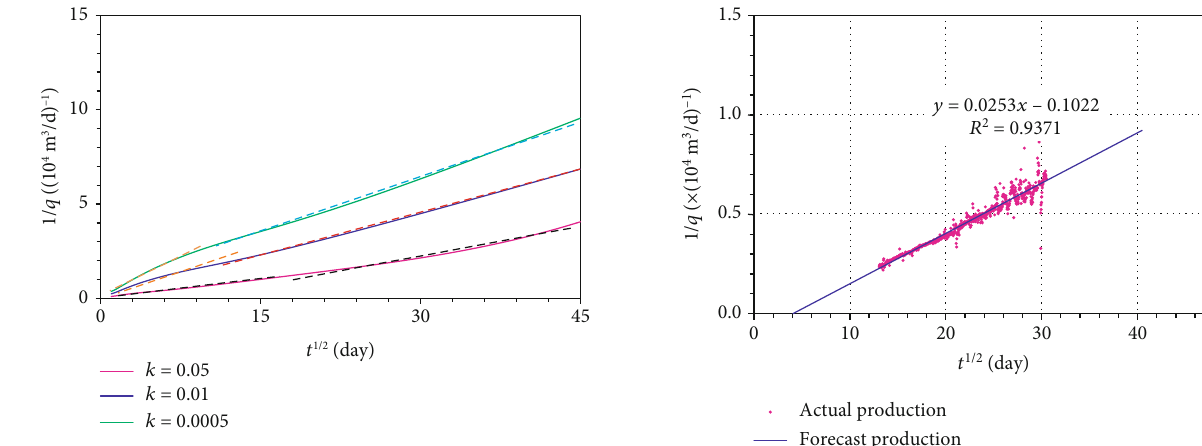
Figure 6: 1/ q vs. t 1/2 matching plot for B well. g